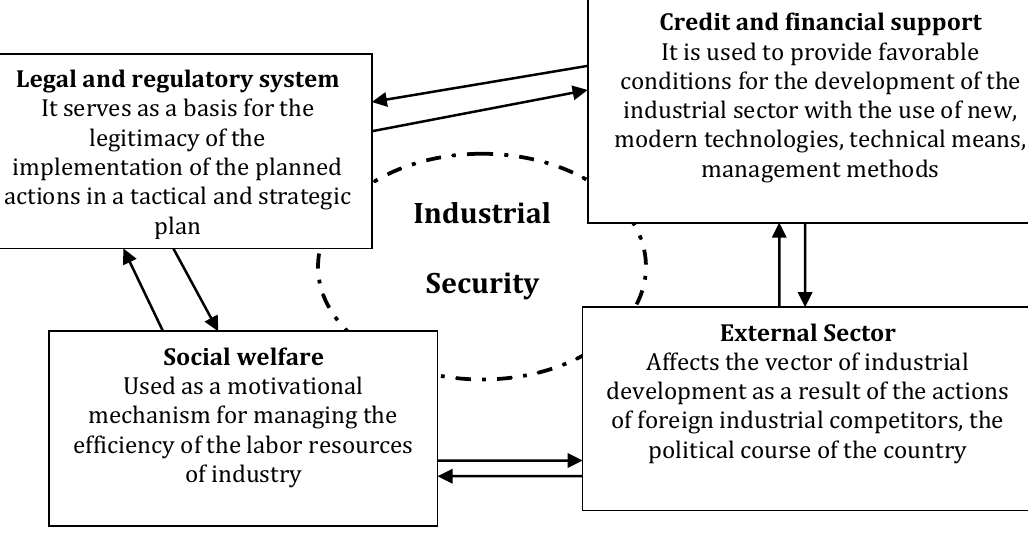
Figure 1: System interaction of the components of the industrial safety vector